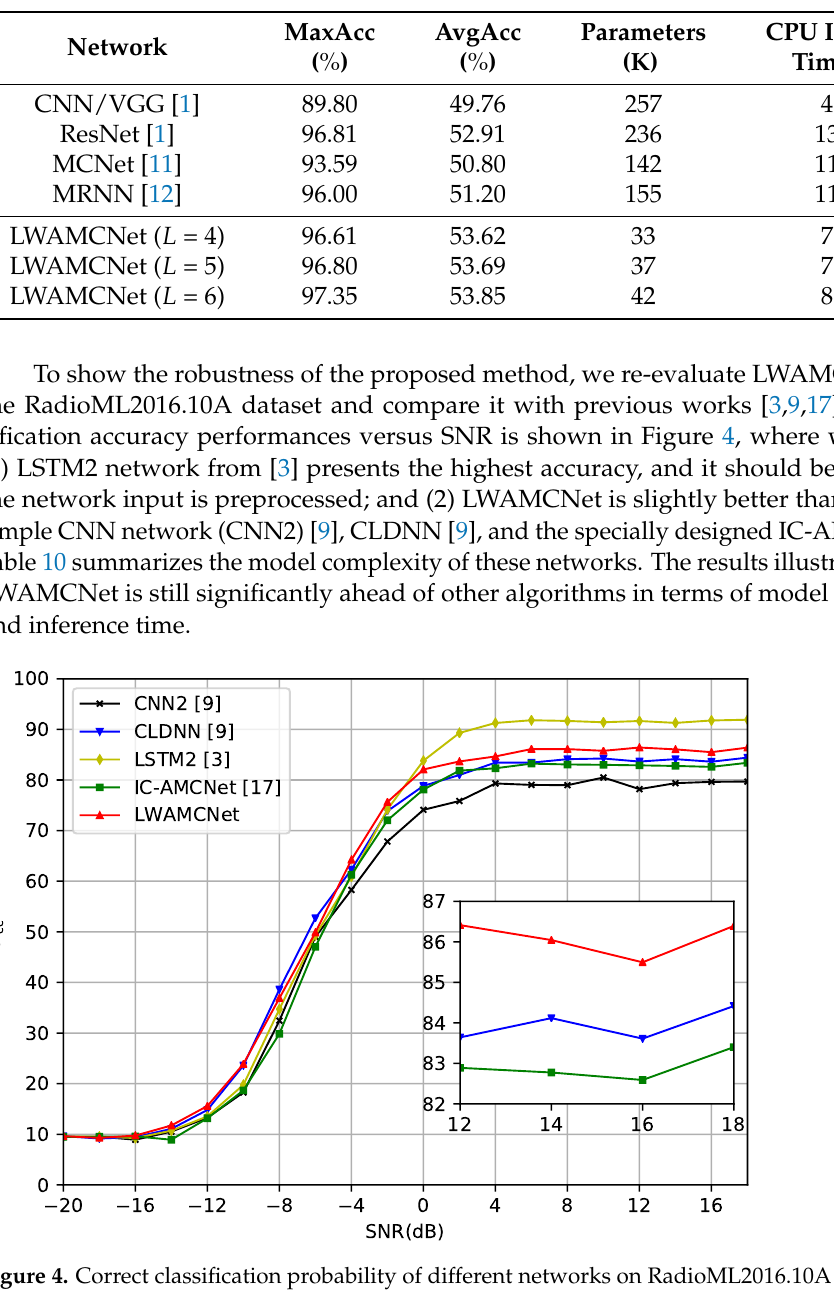
Table 9. Performance comparison using RadioML2018.01A dataset.